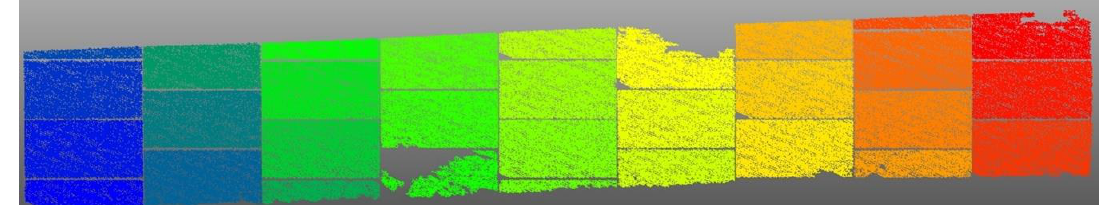
Figure 15. An example of segmented textured MSE wall panels (different colors represent different segmented panels).